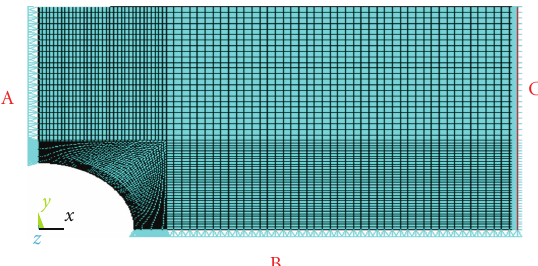
Figure 7: Finite element